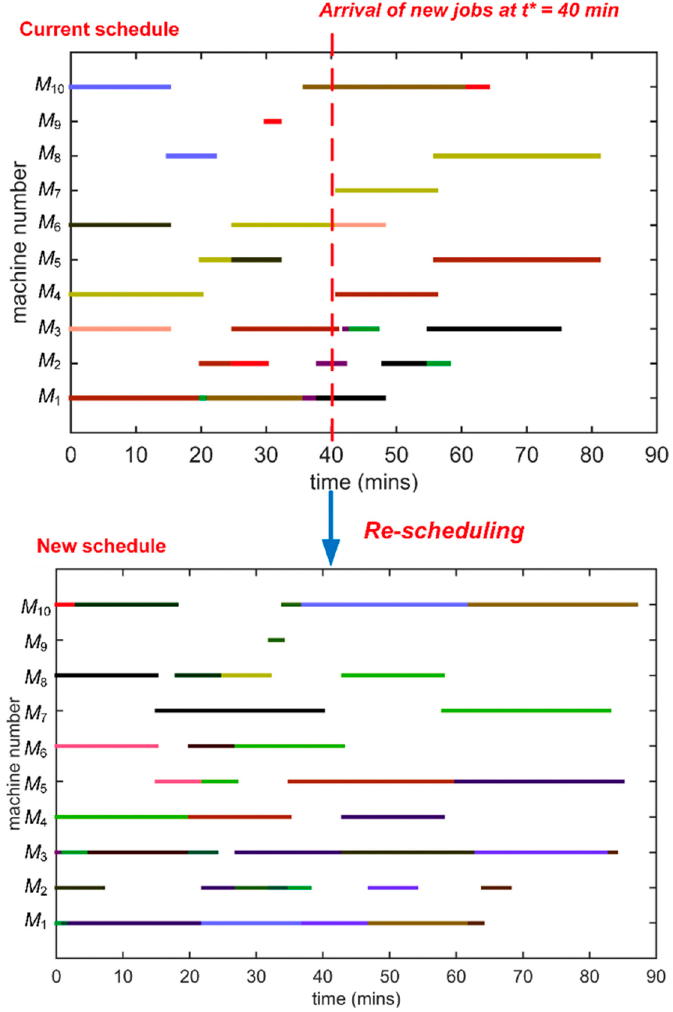
Figure 10. Dynamic scheduling capacity of the developed solver.